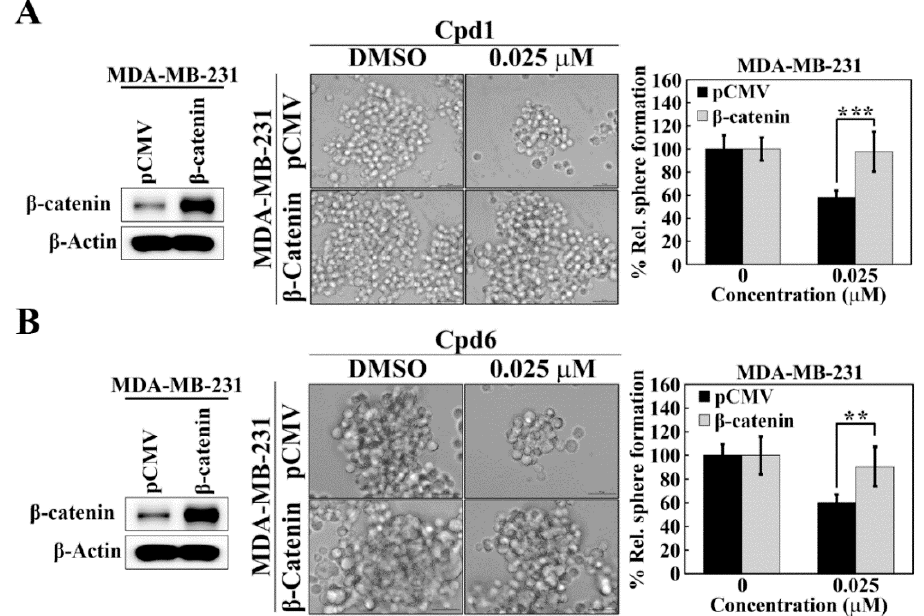
Figure 6. β -Catenin is involved in Hsp70-mediated regulation of cancer stem cells in MDA-MB-231 cells. ( A ) Effects of ectopic expression of β -catenin versus pCMV vector control on mammosphere formation in compound 1 treated MDA-MB-231 cells. Left, Western blot analysis of β -catenin expression in ectopic expression of pCMV vector and β -catenin in MDA-MB-231 cells. Middle, representative images showing the effect of ectopic expression of β -catenin versus pCMV vector control on mammosphere formation in compound 1 treated MDA-MB-231 cells (100 × magnification). Right, quantitative results of mammosphere formation. Data, means ± S.D., *** p < 0.001. ( B ) Effects of ectopic expression of β -catenin versus pCMV vector control on mammosphere formation in compound 6 treated MDA-MB-231 cells. Left, Western blot analysis of β -catenin expression in ectopic expression of pCMV vector and β -catenin in MDA-MB-231 cells . Middle, representative images showing the effect of ectopic expression of β -catenin versus pCMV vector control on mammosphere formation in compound 6 treated MDA-MB-231 cells (100× magnification). Right, quantitative results of mammosphere formation. Data, means ± S.D., ** p < 0.01.